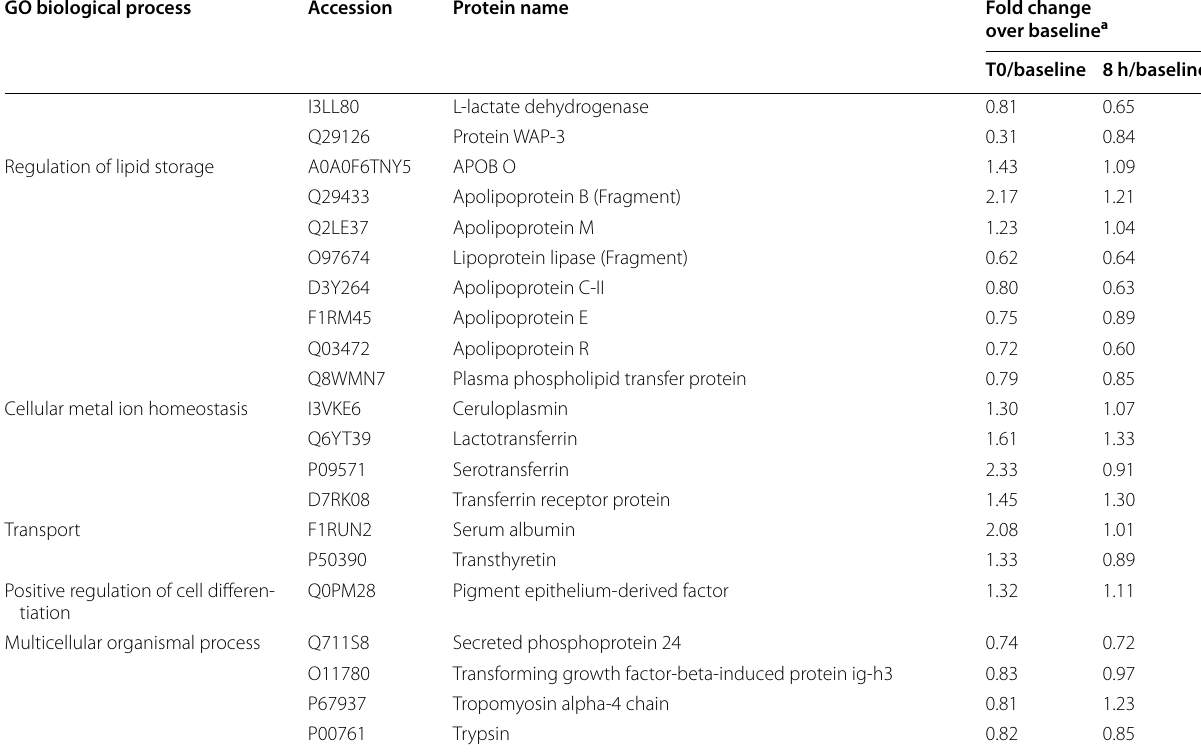
(Additional file 8: Table S3, Additional file 9: Table S4, Additional file 10: Table S5, Additional file 11: Table